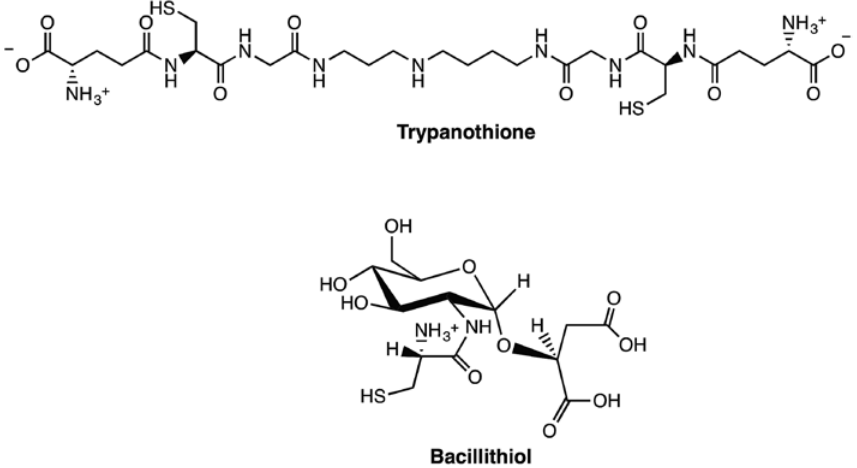
Figure 5: Chemical structures of trypanothione and